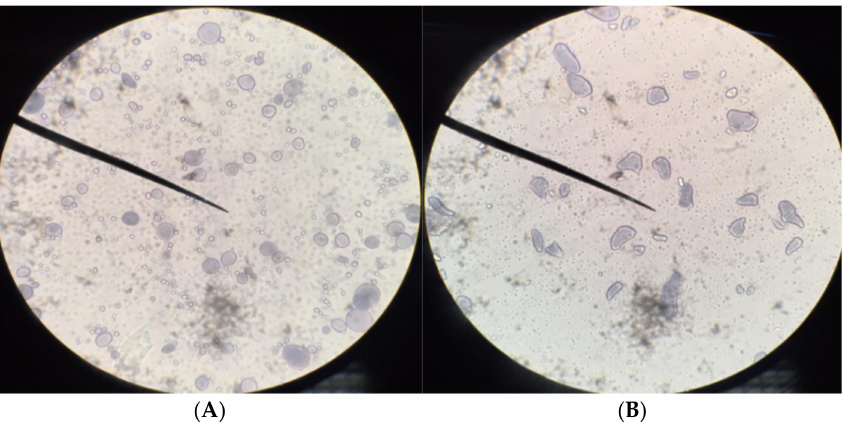
Figure 1. Starch granules (40 × magnification) of wheat flour ( A ) and unripe banana flour ( B